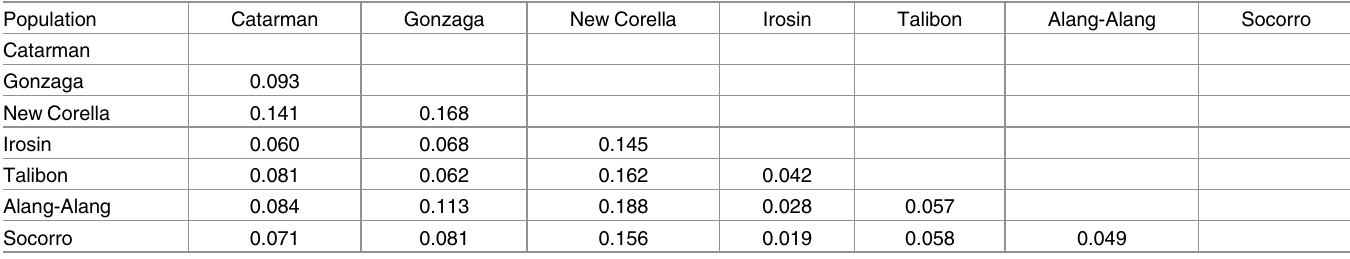
Table 2. Pairwise genetic differentiation (F ST ) among populations based on 10 microsatellite loci a . Population